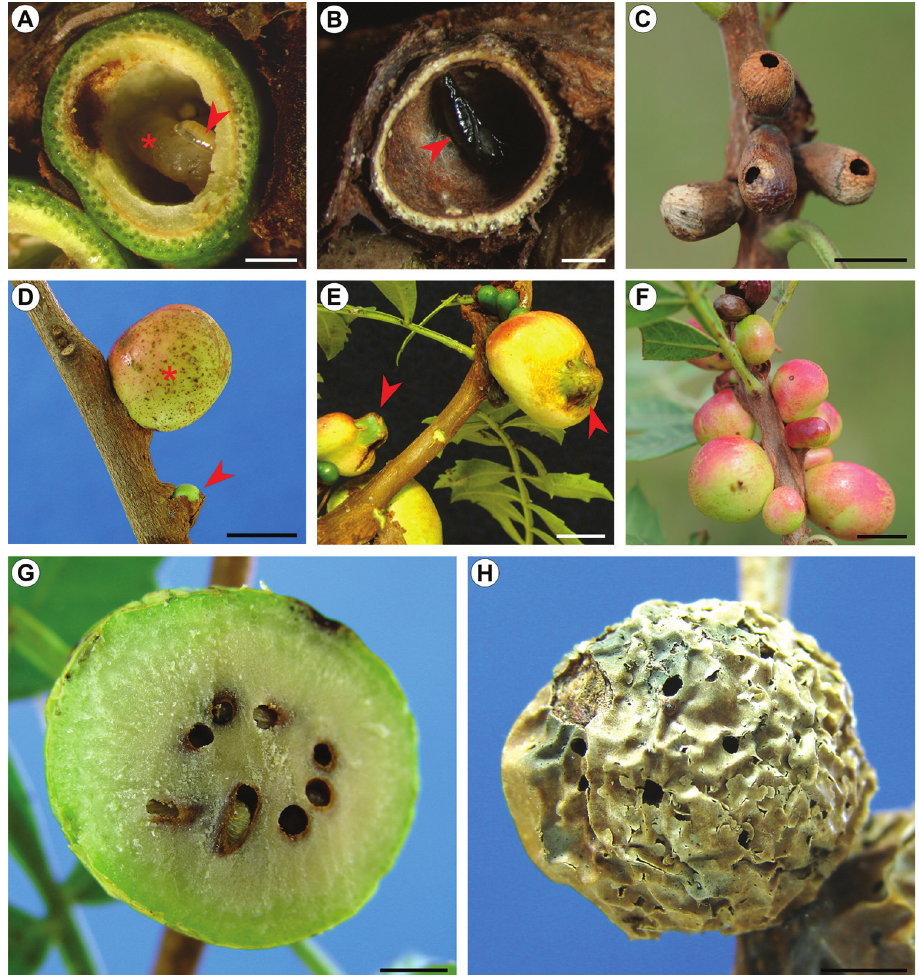
Figure 10. Hymenoptera fauna associated with C. pampeanus galls. A transversally sectioned, externally developing gall, showing inside a larva of C. pampeanus (asterisk) with attached larva (arrow) of Lyrcus sp. (Pteromalidae) B transversally sectioned, dried gall, with pupa of Lyrcus (arrow), after consumption of C. pampeanus larva C dried and empty attached galls showing orifices of emergence left by adults of Lyrcus D young, erupting, free of inquiline and adjacent inquiline attacked ( Allorhogas sp., Braconidae) galls, indi- cated respectively by open arrow and asterisk E young galls of C. pampeanus (arrows) partially involved with gall tissue induced by inquilines F variation in size among Allorhogas galls early attacked G a full-developed inquiline-attacked gall showing larvae and pupae in cameras inside H senescent Allorhogas gall showing orifices of emergence (arrows) left by adults. Scale bars: 1 mm ( A, B, D, F ); 5 mm ( C ); 0.5 mm ( E, G, H